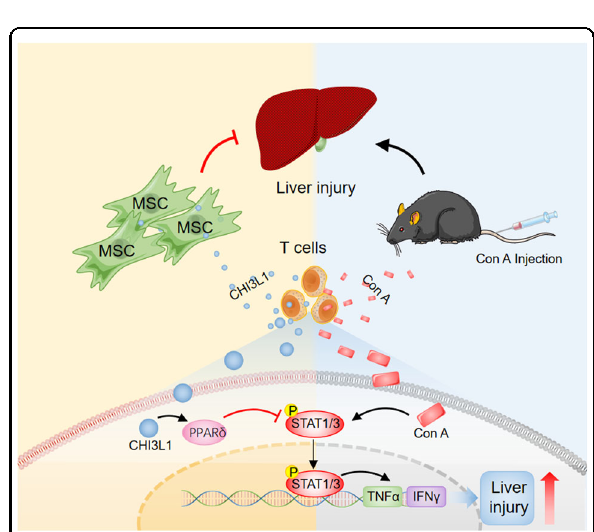
Fig. 7 hUC-MSCs alleviate experimental immune-mediated liver injury via CHI3L1-mediated T cell suppression. Schematic demonstration of the main message of our